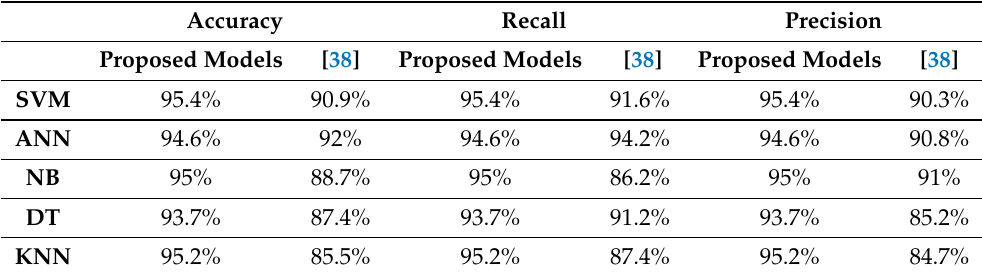
Table 5. Models’ comparison in terms of accuracy, recall and precision. Accuracy Recall Precision Proposed Models Proposed